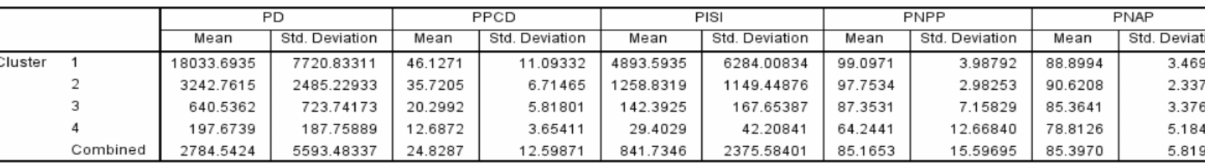
Figure A2. Centroids of